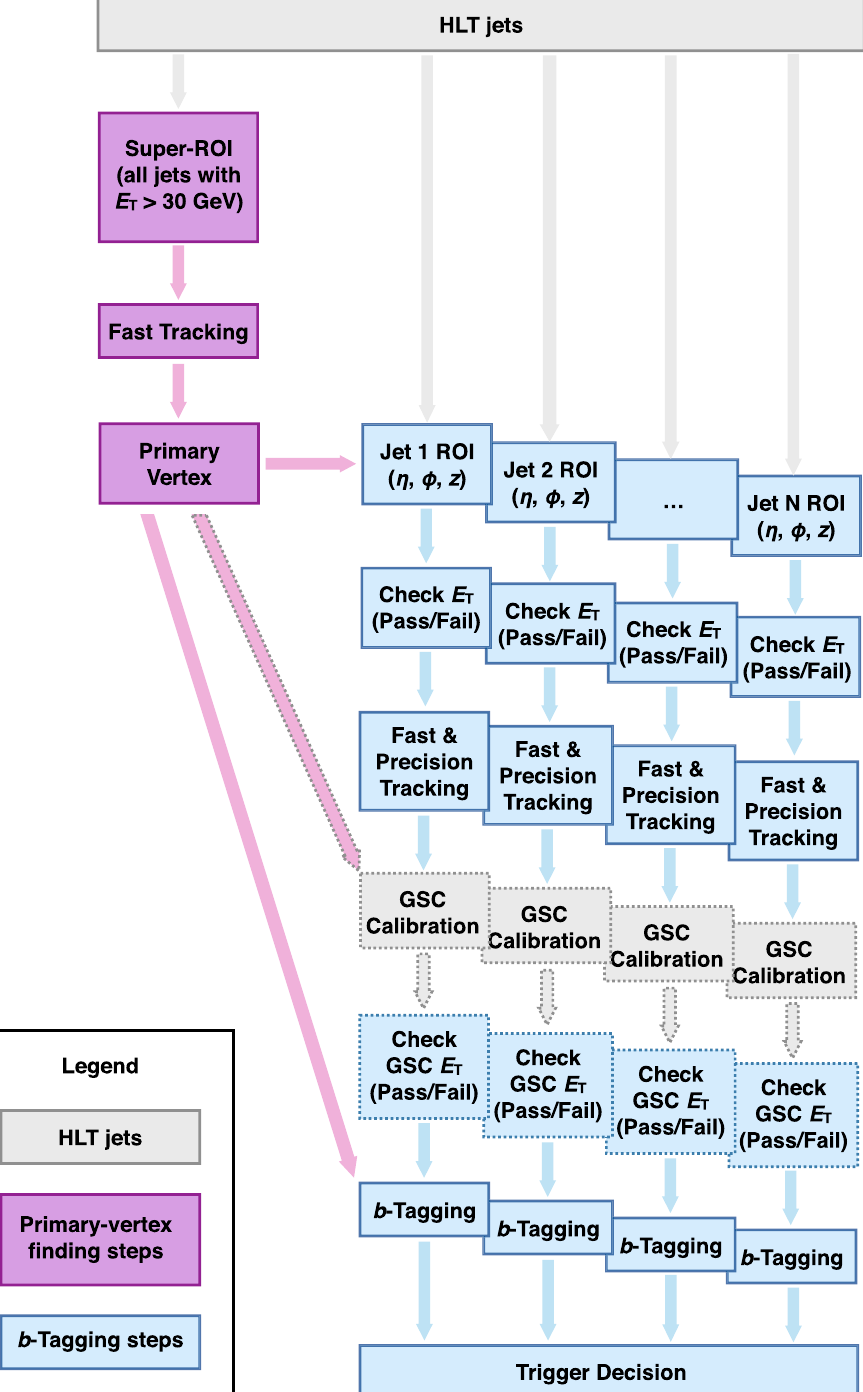
Fig. 7 A schematic overview of the different components of the b -jet trigger sequence. HLT jets (grey boxes) are used as inputs to the primary-vertex finding (pink boxes) and b -tagging of jets that point towards the primary vertex (blue boxes). The GSC (dashed outline), as provided by the HLT jets (described in Sect. 4.3) can be applied as an optional step and in this case a second requirement is placed on the jet E T , using the calibrated